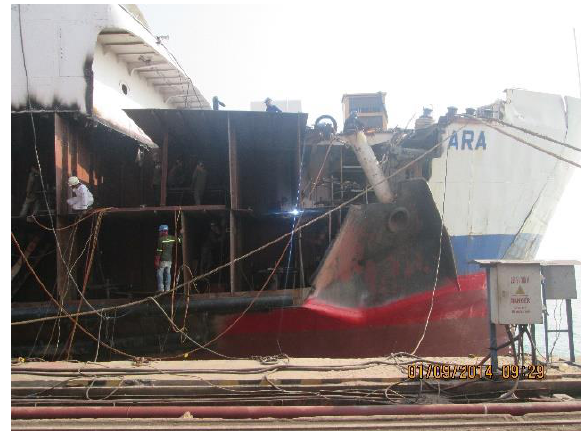
Figure 2: Repair process of side structure after a collision incident.